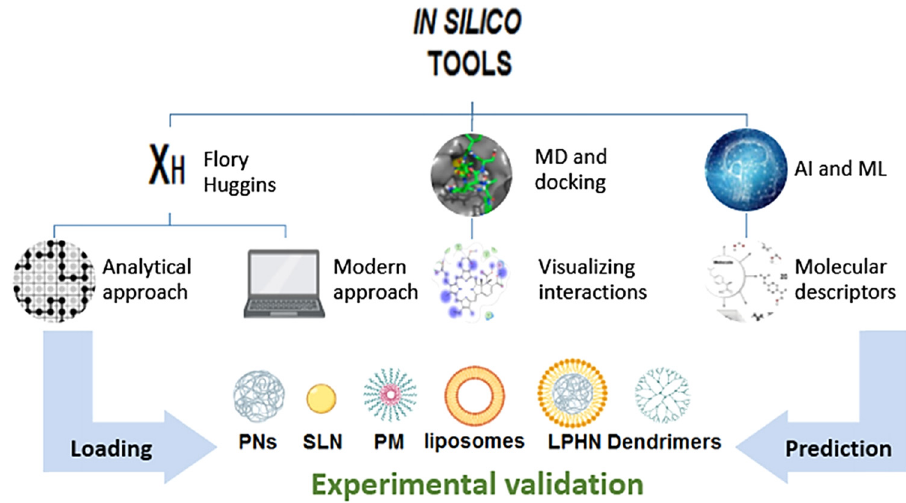
Figure 8: Contribution of di ff erent analytical and in silico tools to the drug loading optimization in di ff erent classes of nanocarrier [ 176 ] .